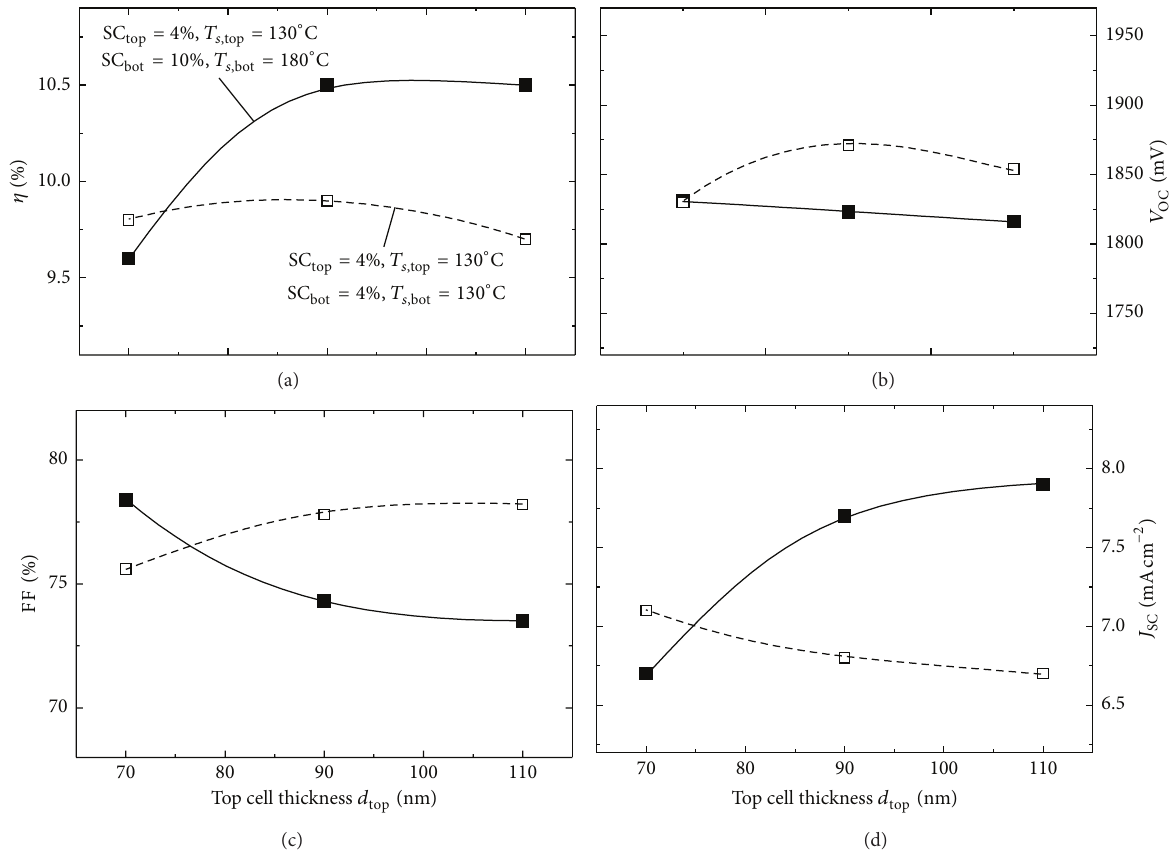
Figure 8: Photovoltaic parameters of the current matching series of two tandem junction solar cells deposited at different SC and 𝑇 𝑠 , as a function of their top cell thickness. The lines are to guide the eye.